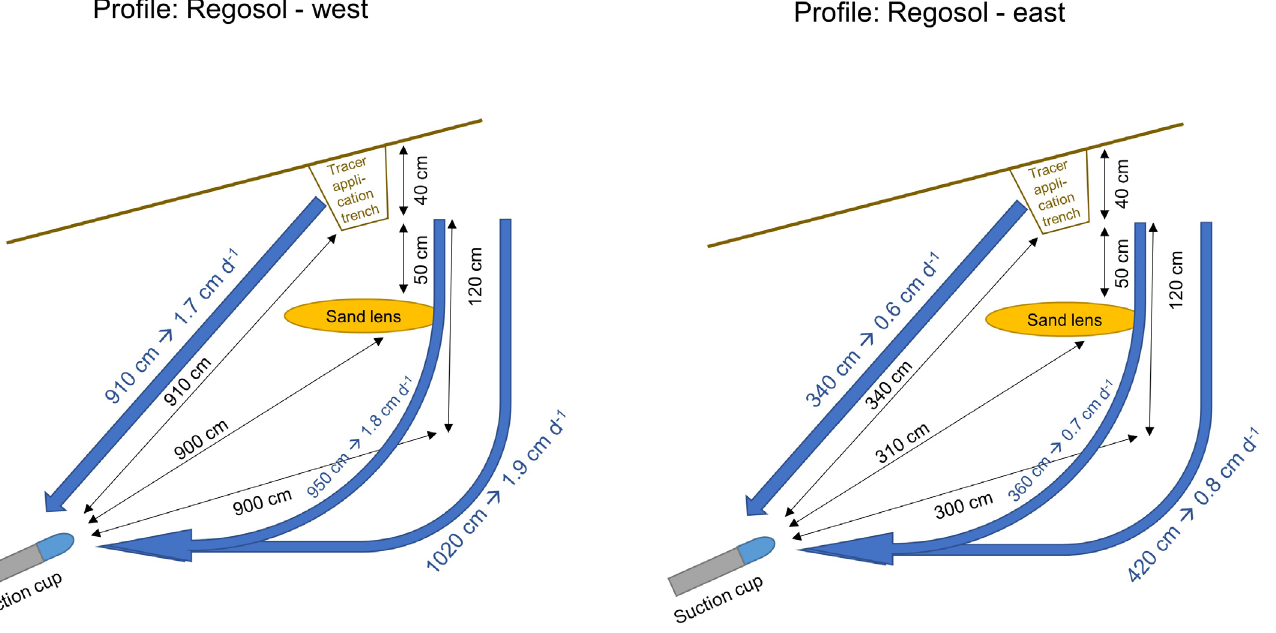
Figure 7. Assumptions for the travel distances of the estimated flow paths (blue arrows) and derived average travel distances per day of the tracer for the Regosol west ( left side ) and Regosol east ( right side ). The three pathways reflect the shortest, the medium, and a relatively long subsurface flow path. Due to the phenomena of dispersion and diffusion, actual flow paths might even be longer than assumed in this sketch.